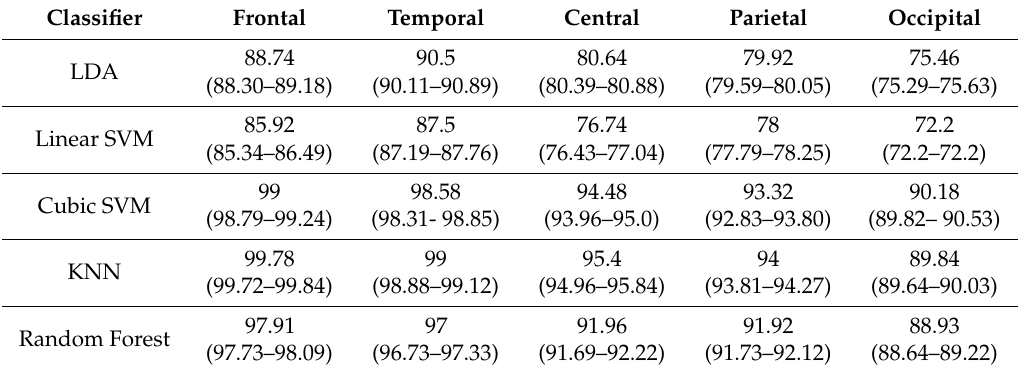
Table 6. Accuracy (95% CI) for evaluating stress levels from di ff erent electrode sites.